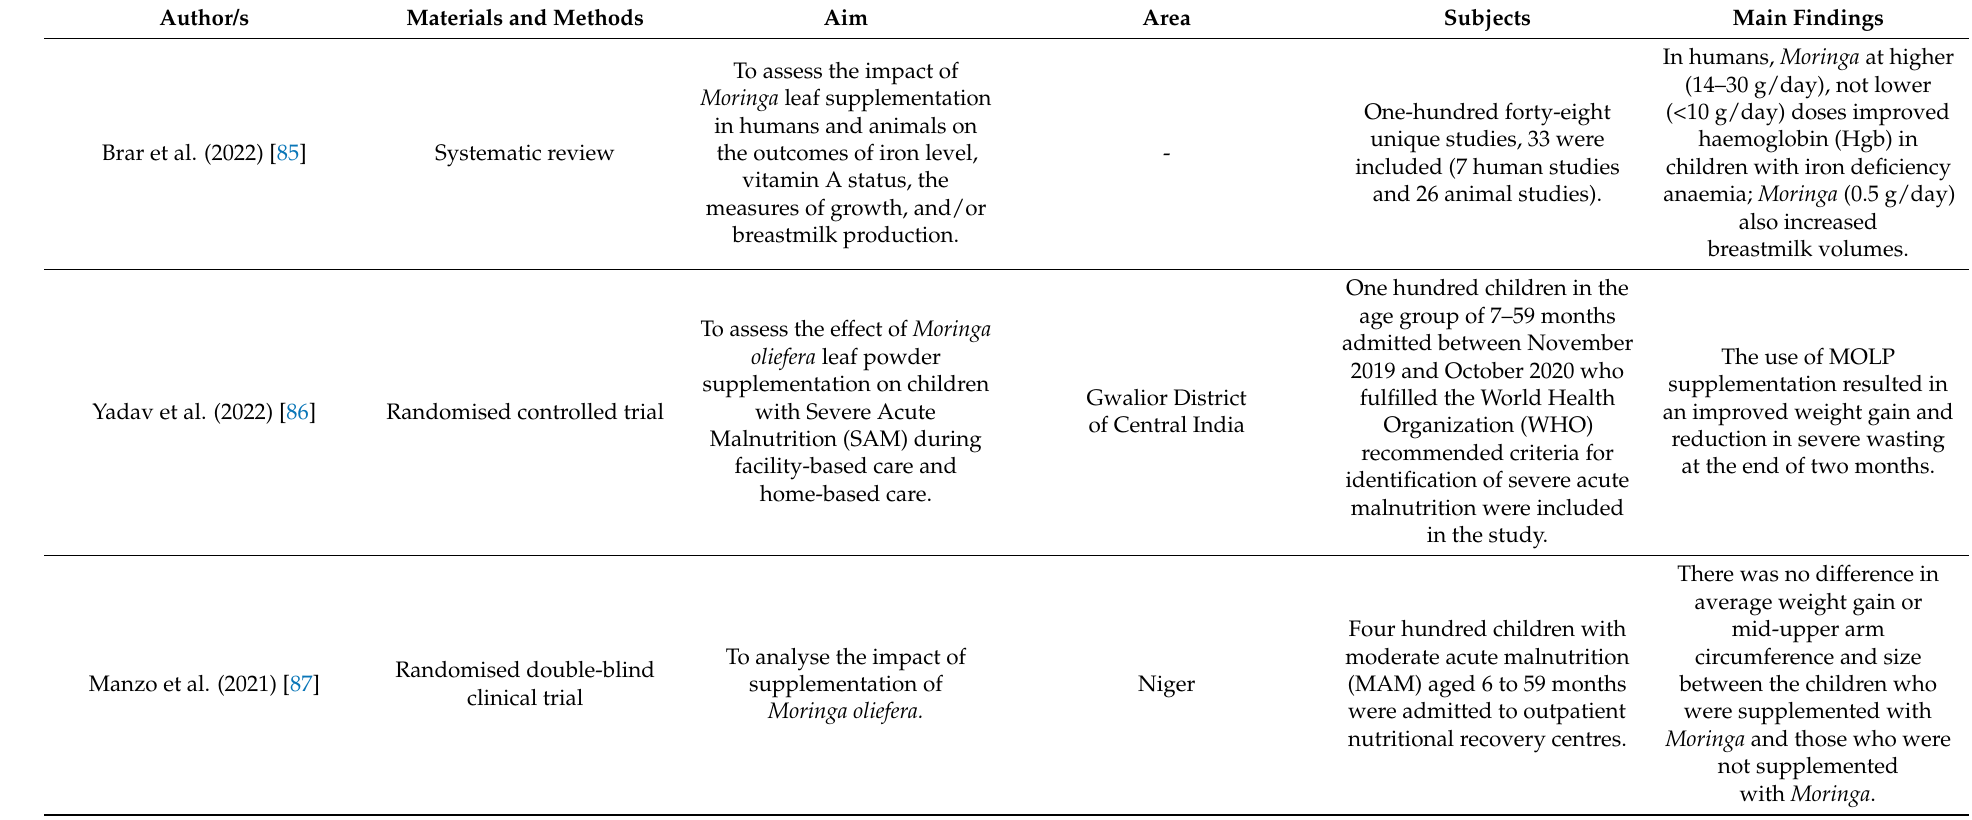
Table 3. Studies on the effectiveness of Moringa as a supplement in the prevention and treatment of undernutrition in